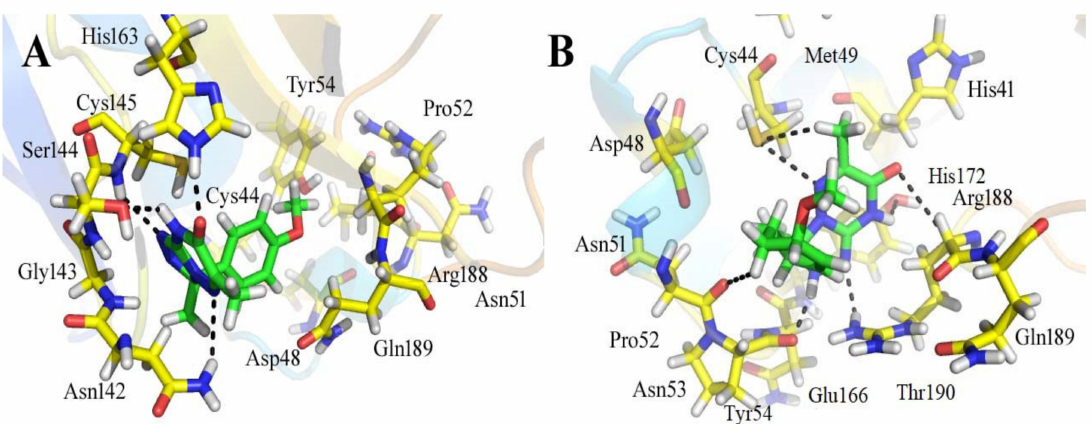
Figure 2. The binding mechanism of the ZINC08535852 ZINC database ligand within the active site of the M pro protein ( A ) before MDS and ( B ) after